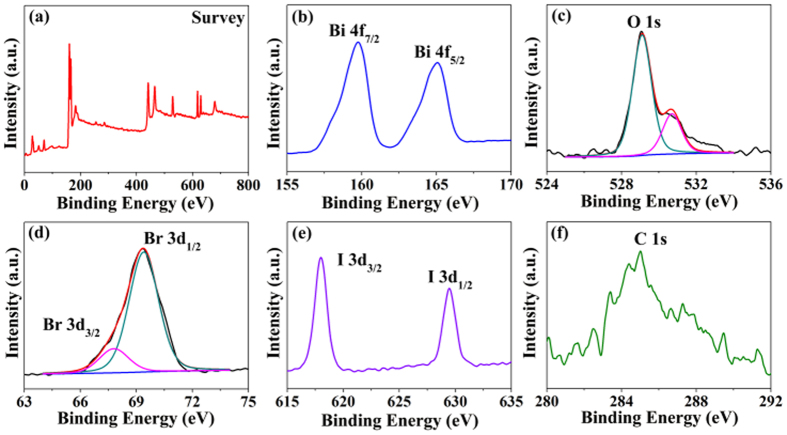
XPS spectra of the BiOBrxI1−x sample with x = 0.8: (a) survey scan, (b) Bi 4f, (c) O 1s, (d) Br 3d, (e) I 3d, and (f) C 1s.